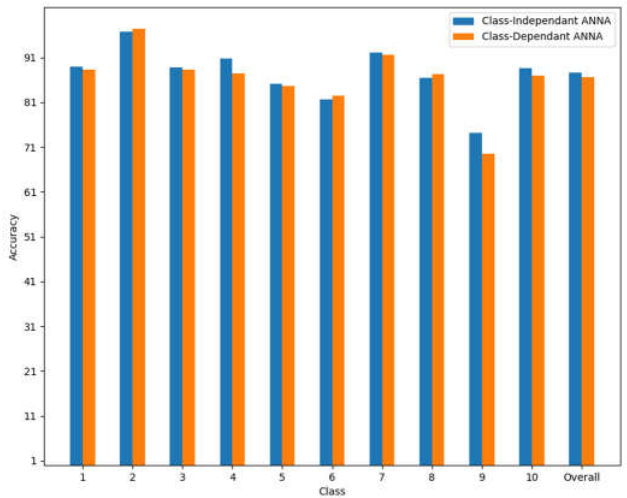
Figure 10. Overall accuracy and per-class accuracies obtained using the proposed ANNA ap- proaches and MNIST dataset.